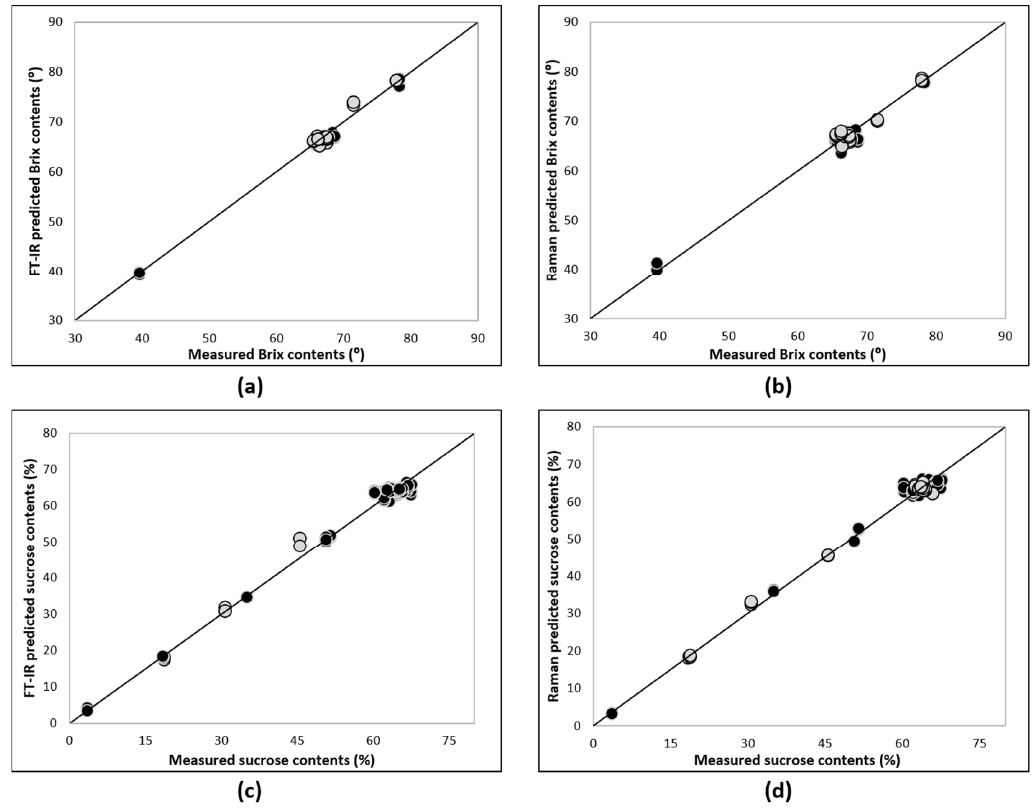
Figure A2. PLSR calibration and validation plots for Brix ( a , b ), and sucrose ( c , d ) in traditional maple syrups, BBL maple syrups, and table syrup samples utilizing 4500 FT-IR and Raman data, respectively. Black circles represent calibration set samples; gray circles represent external validation set samples.